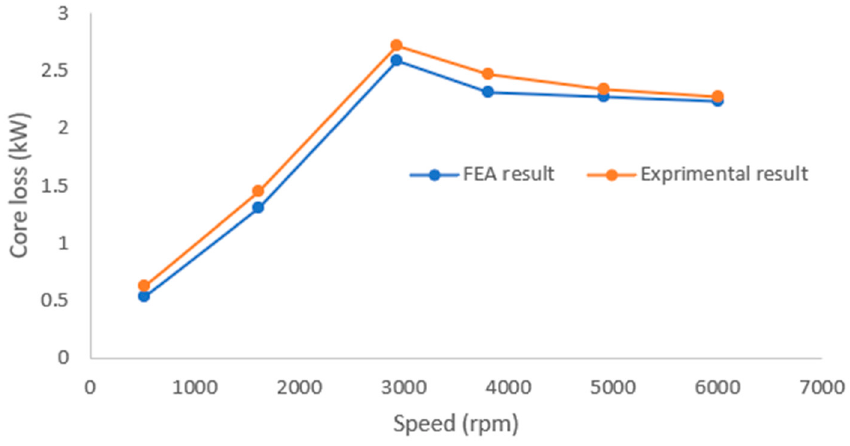
Figure 21. Comparison curve of core loss measurement and calculation.